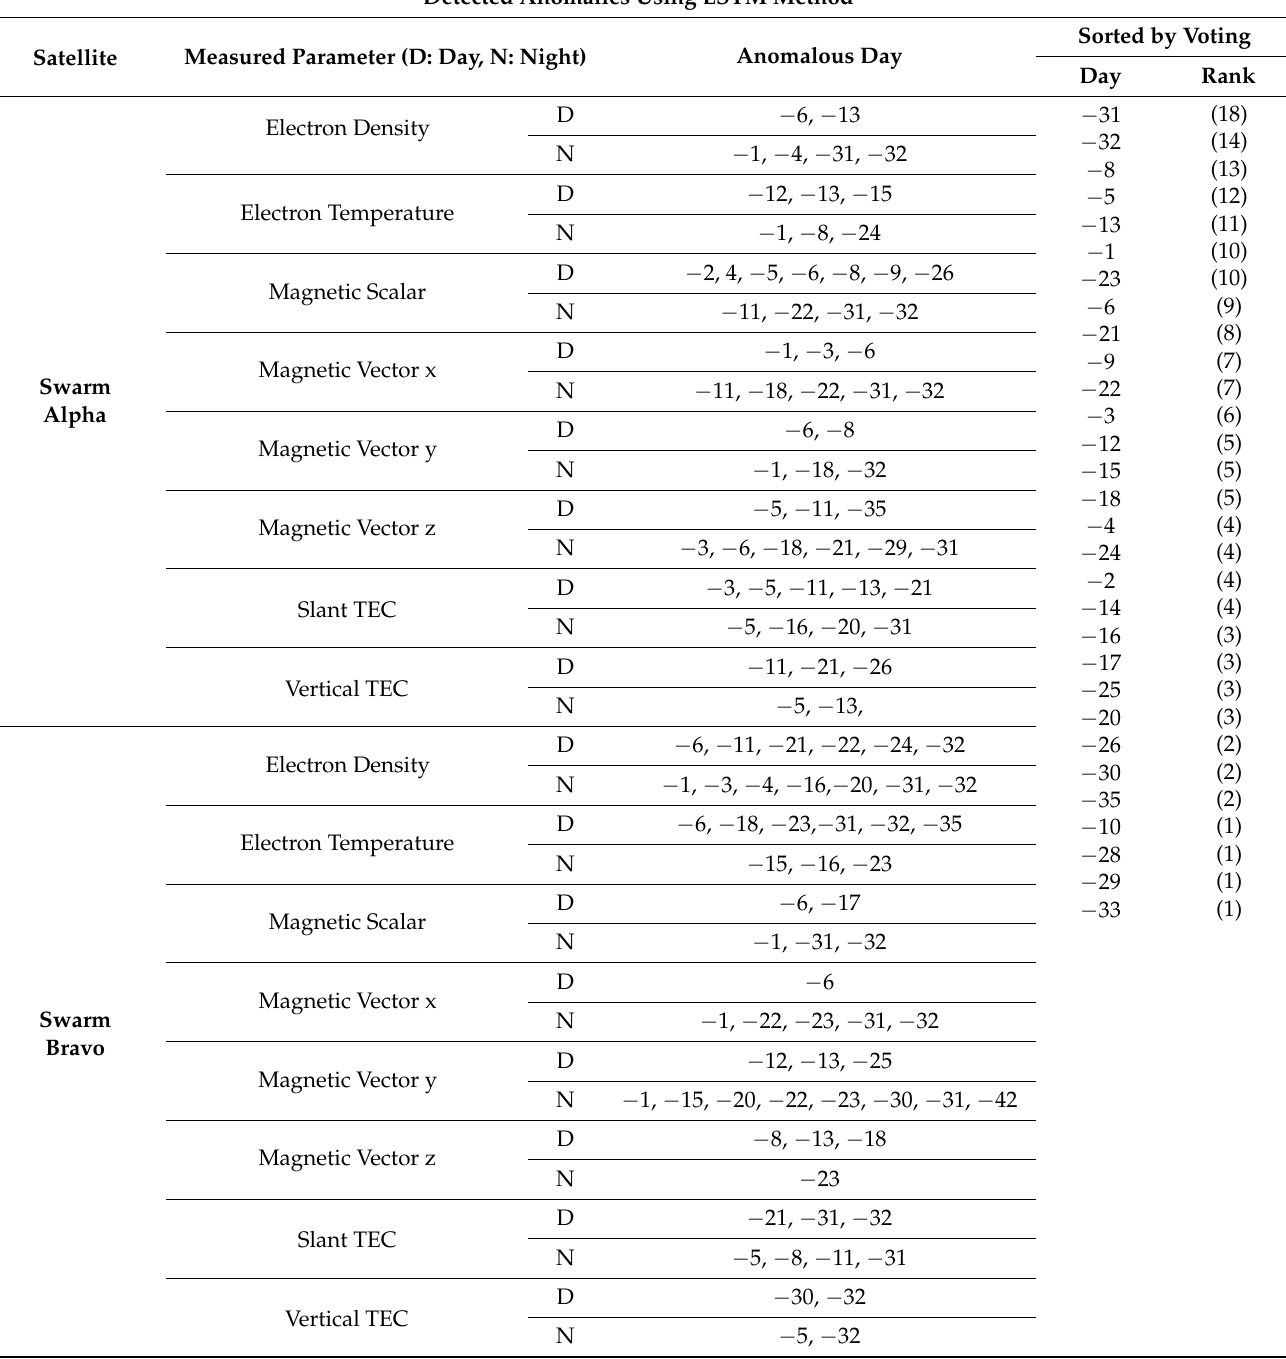
Table 3. The observed anomalies using LSTM